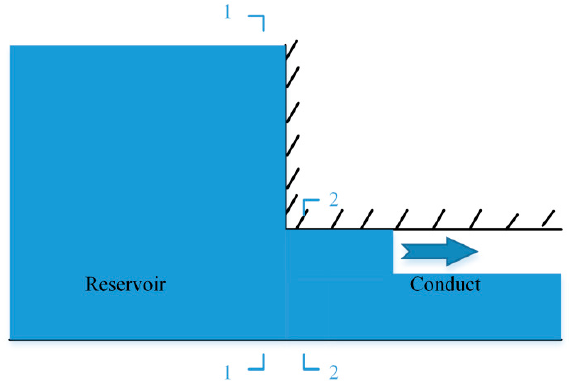
Figure 2. Front view of the benchmark model.